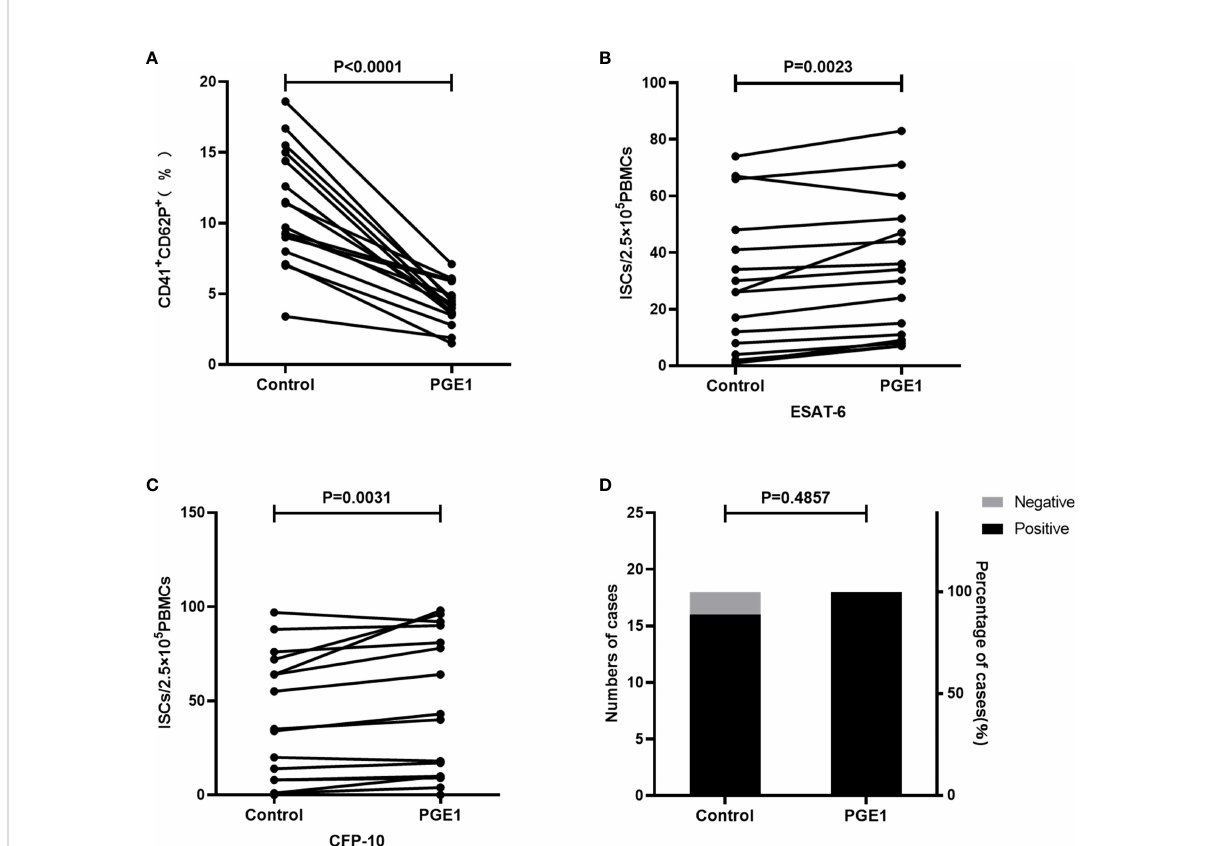
FIGURE 6 The numbers of ISCs and the positive results of T-SPOT were increased after inhibition of platelet activation. PBMCs were isolated and PGE1 was used to prevent platelet activation during the isolation procedure, followed by PBMCs being used for the T-SPOT assay (n=16). (A) The expression of CD62P on platelets in PBMCs before and after PGE1 treatment was measured by FCM and compared by paired Student ’ s t-test. The ISCs in response to (B) ESAT-6 and (C) CFP-10 stimulation were counted and compared by paired Student ’ s t-test. (D) The positive rates of the T-SPOT assay were compared by the chi-square